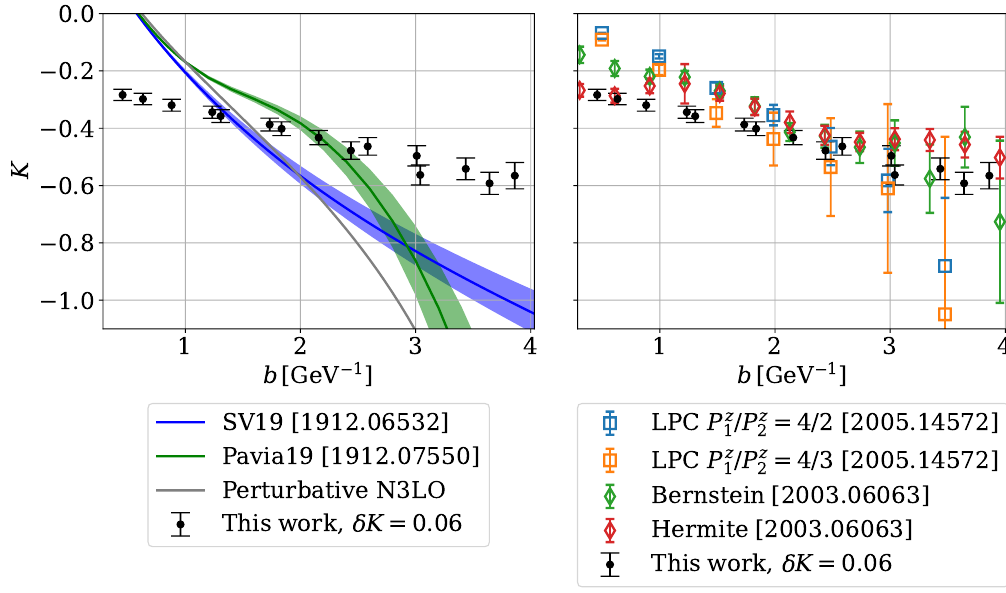
Figure 10 . Comparison of the CS kernel extracted in this work to phenomenological extractions (left) and lattice computations (right). The comparison is made at µ = 2